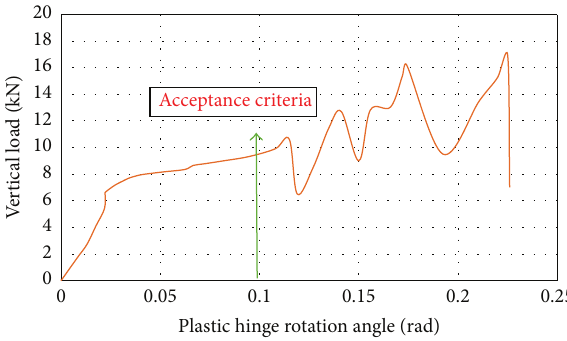
Figure 14: Vertical load versus plastic hinge rotation angle for progressive collapse